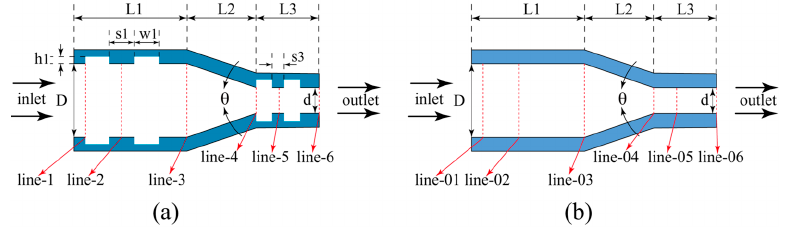
Figure 13. Line plan:( a ) BSCN; ( b ) conventional straight cone